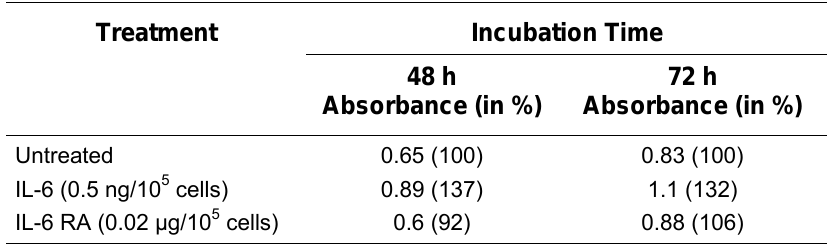
Effects of IL-6 and IL-6RA on the DNA Synthesis of MM RPMI-8226